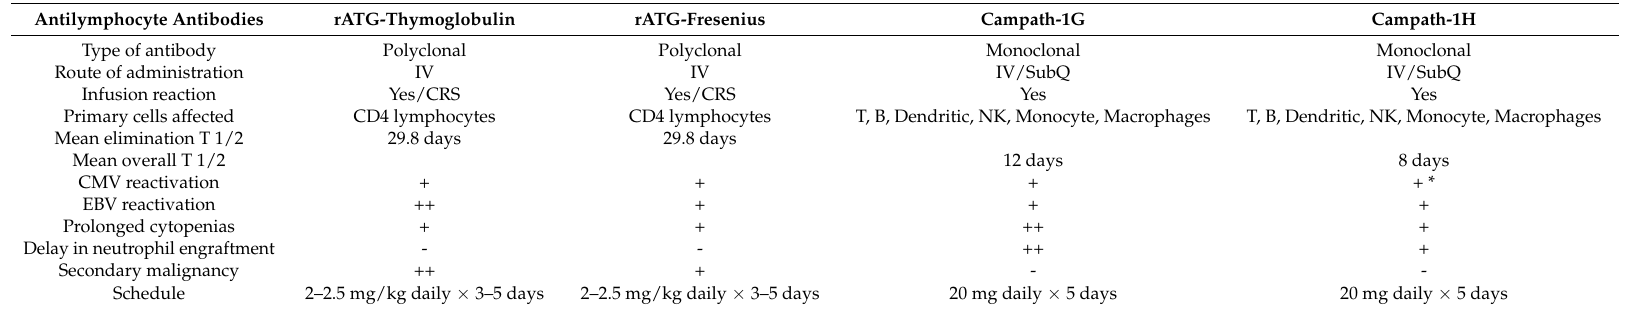
Table 1. Comparing pharmacology of anti-thymocyte globulin (ATG) to that of